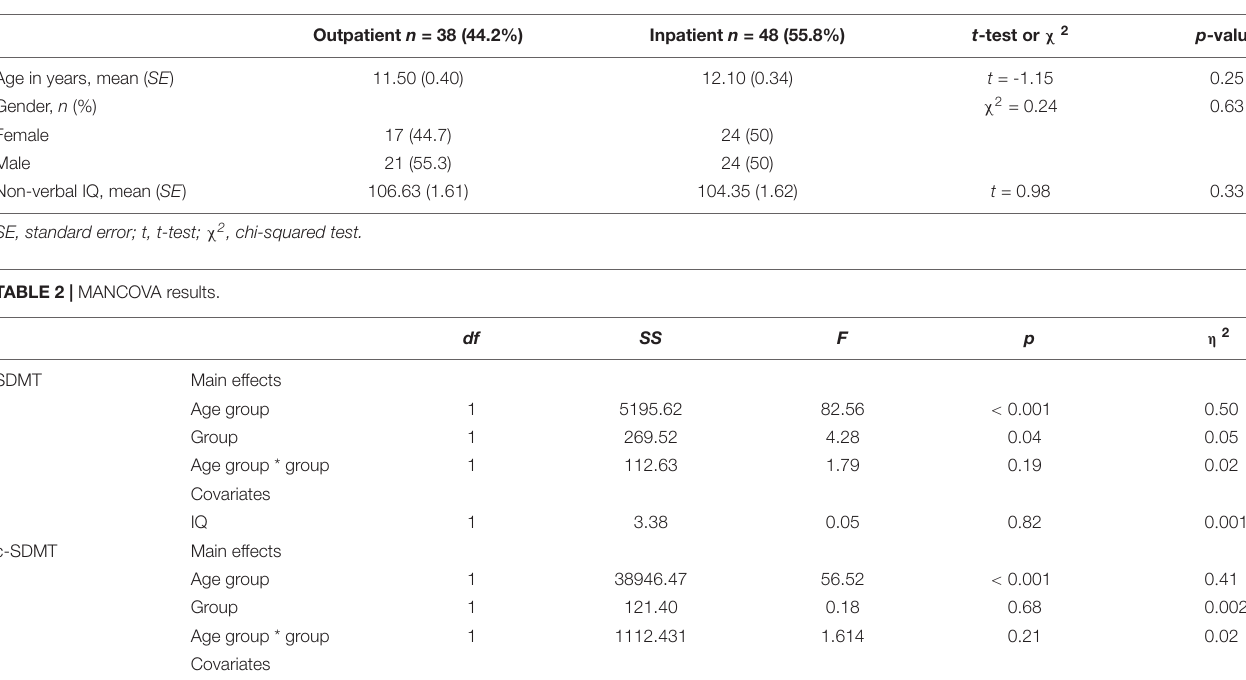
TABLE 1 | Demographic data on the outpatient and inpatient participants.